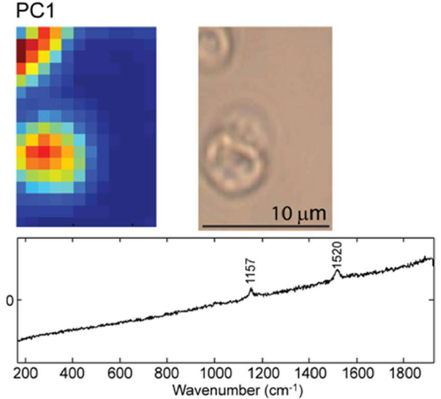
Figure 3. Top left: Raman map of beta-carotene loaded microcapsules. Top right: Microscopy image of beta-carotene microcapsules. Bottom: The corresponding loading plot of the relevant principal component